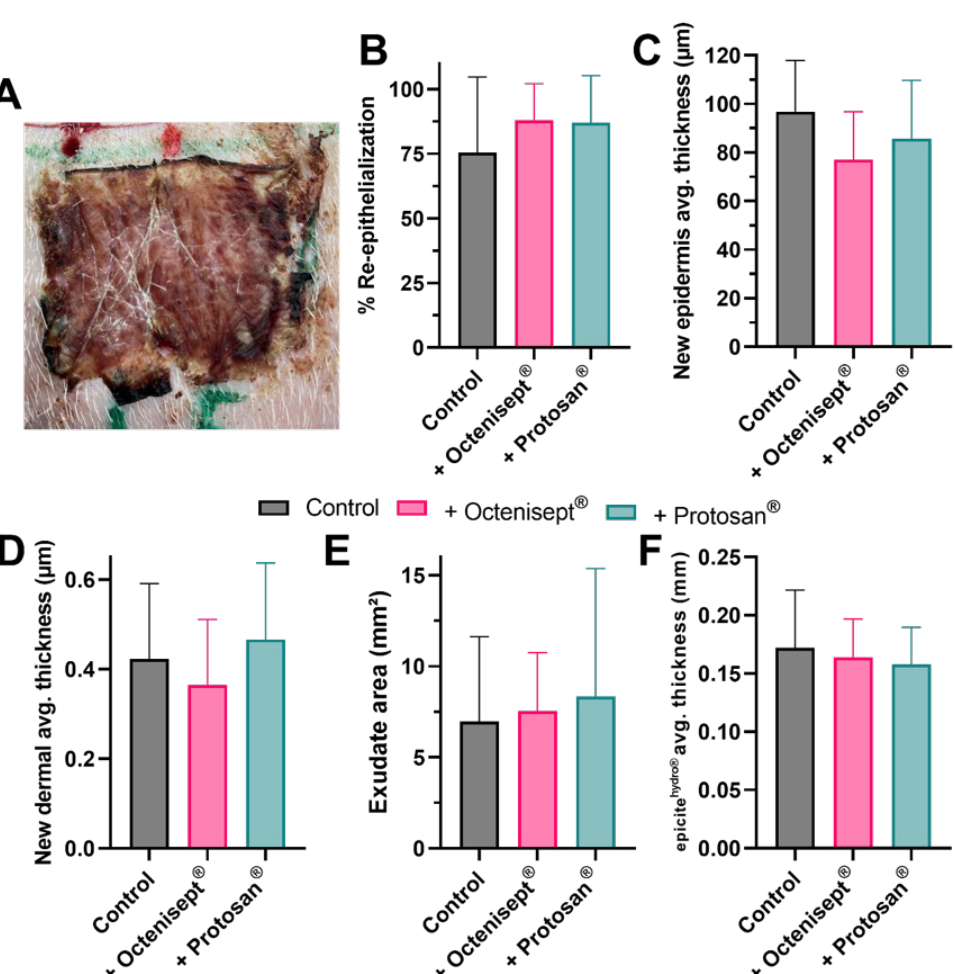
Figure 5. Influence of a 7-day treatment using antiseptics on the wound healing process outcome. Representative image of an epicite hydro® dressing applied over the wound bed after the 7-day treatment. ( A ). Bar diagrams comprising the results for the percentage of re-epithelialization ( B ), average new epidermal thickness ( C ), average new dermal thickness ( D ), exudate area at day 7 ( E ) and epicite hydro® dressing average thickness at day 7 ( F ) for the wounds treated using epicite hydro® alone or combined with Octenisept ® or with Prontosan ® . The results are presented as mean and standard deviation of the mean.